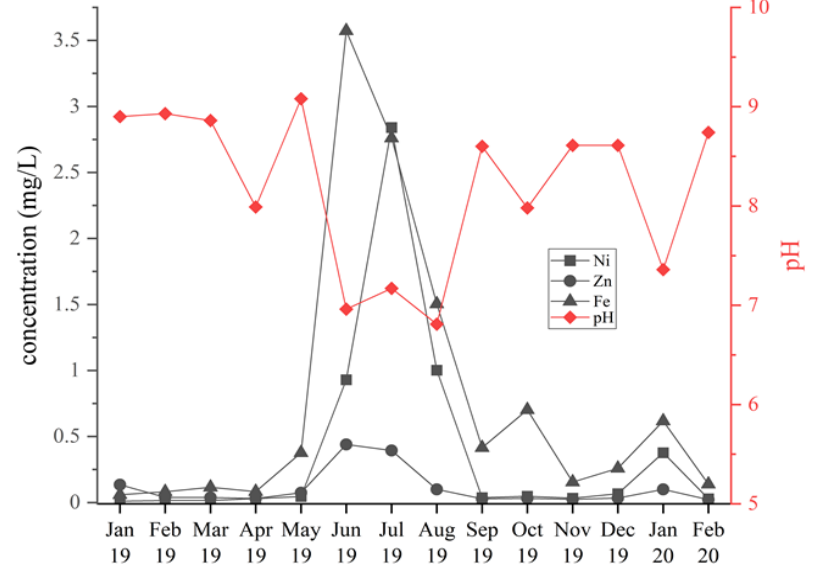
Figure 2. Temporal variation of dissolved trace elements at sampling site 1 and change in pH during the same period of time (second y -axis).